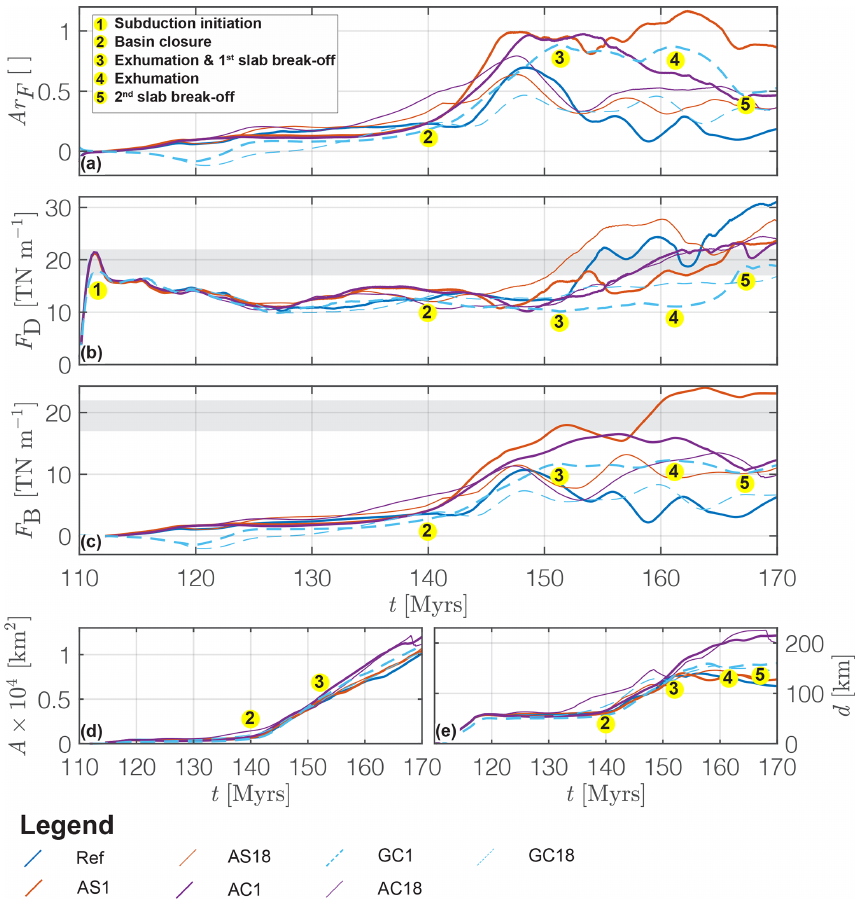
Figure 11. Force evolution. (a) Ratio of buoyancy force to shear force, Ar F , (b) shear forces, (c) buoyancy forces, (d) average area of subducted material and (e) maximum depth of subducted crust. For a detailed explanation on the calculation of quantities see Appendix C. Numbering in all panels exemplified for model GC1: 1 = onset of subduction initiation, 2 = basin closure and onset of continental subduction, 3 = onset of continental crustal exhumation and first slab detachment, 4 = onset of the second exhumation event and 5 = onset of the second slab